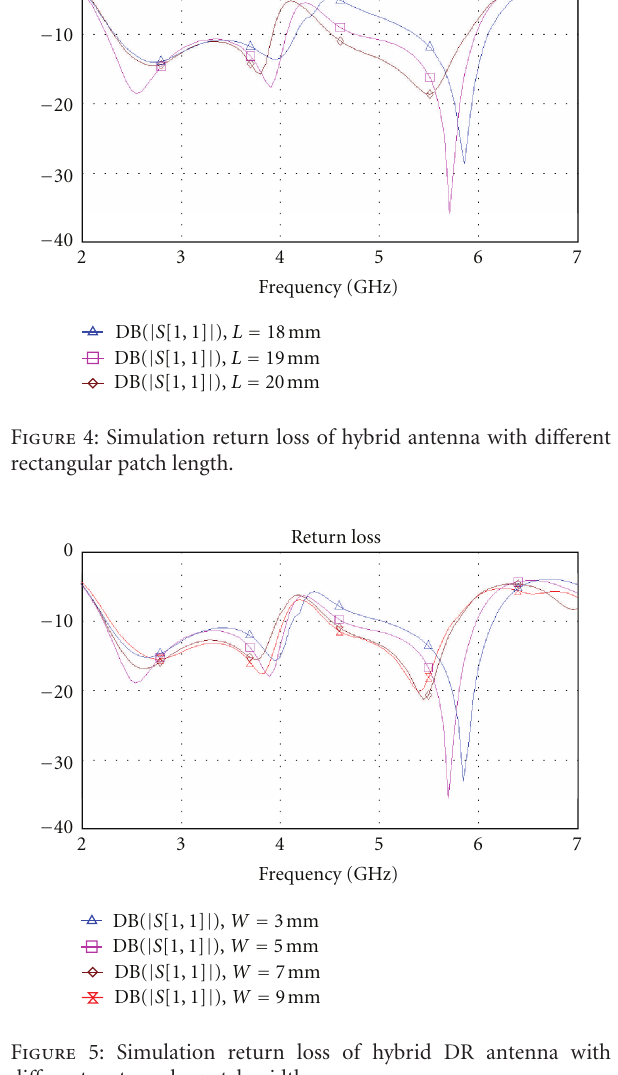
Figure 3: Simulation return loss of hybrid DR antenna with di ff erent DR permittivity.